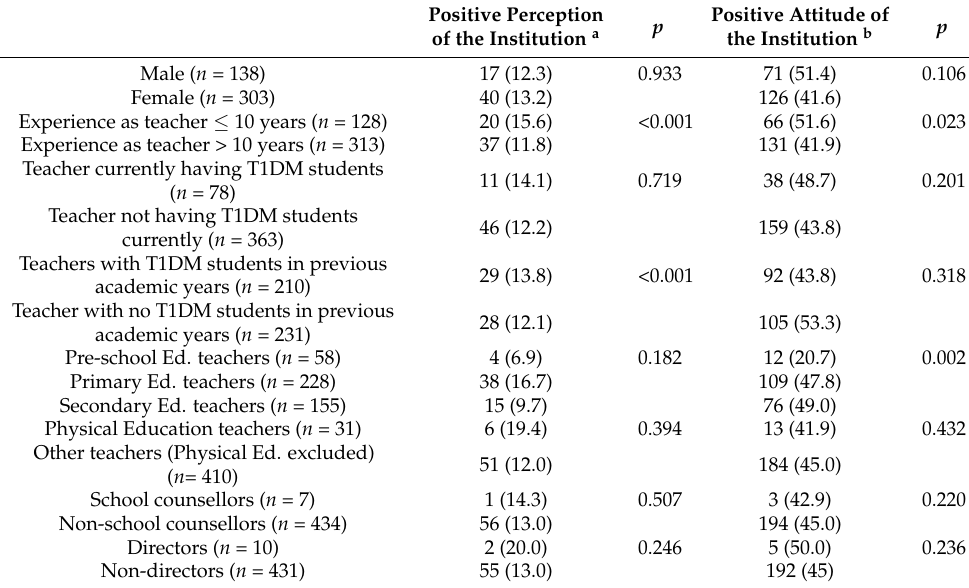
Table 3. Univariate analysis on attitudes and perceptions of teachers about their and their institu- tions ´ management of T1DM.